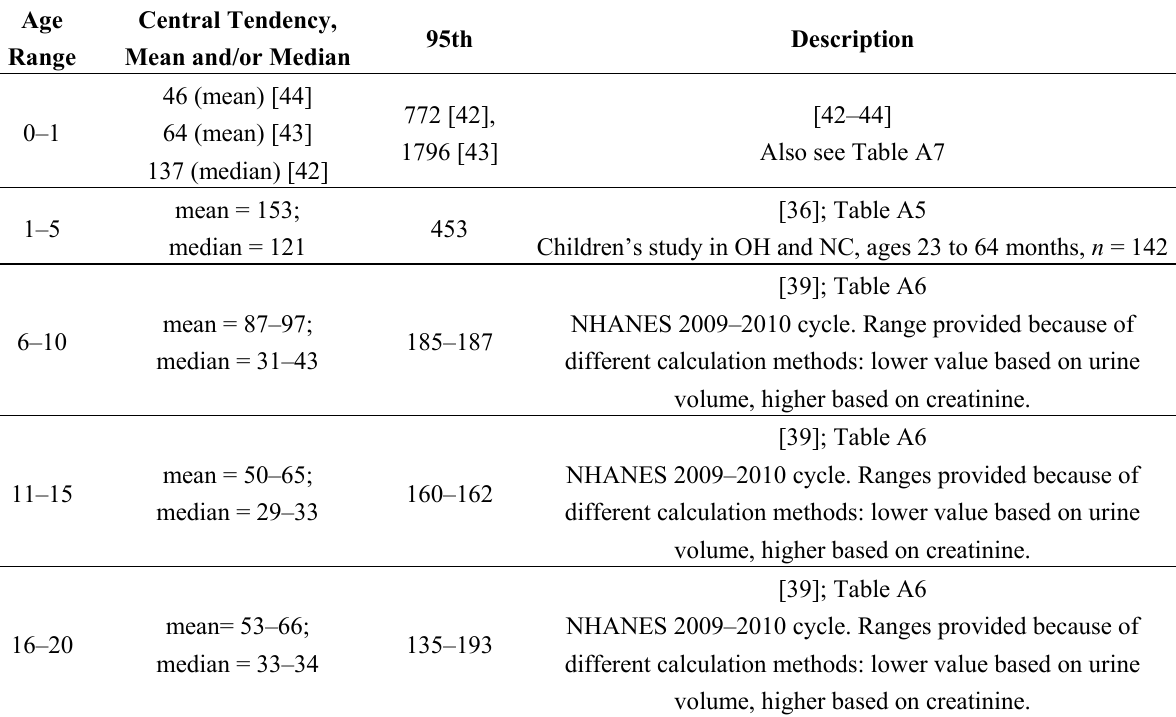
Table 3. Summary of intakes derived from biomonitoring data (intakes in ng